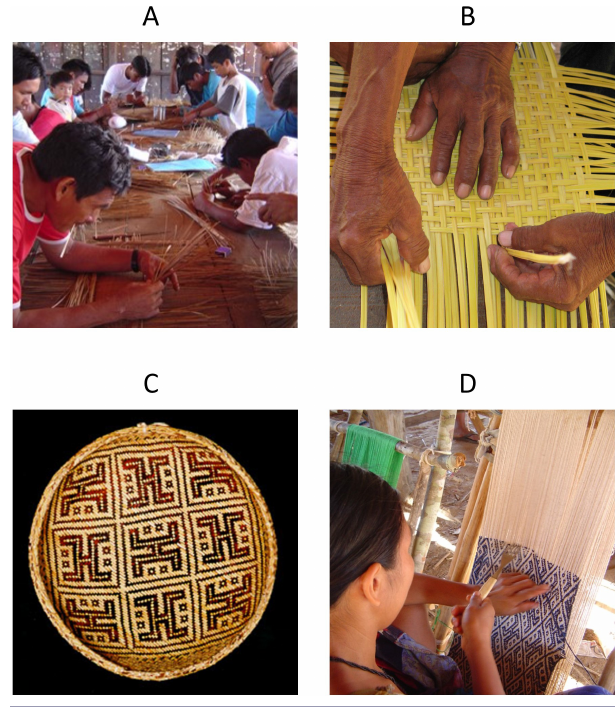
Fig. 6 . Highlights from the Kaiabi Araa project workshops. A. and B. men learning-by-doing in a community of practice; some young men are using the book with basketry photo catalogue. C. Basket showing the Kururu’i design (little frog). D. More (Kaiabi teacher, Tuiararé village) weaving the Kururu’i design on a strap for carrying babies. Photos by: Simone